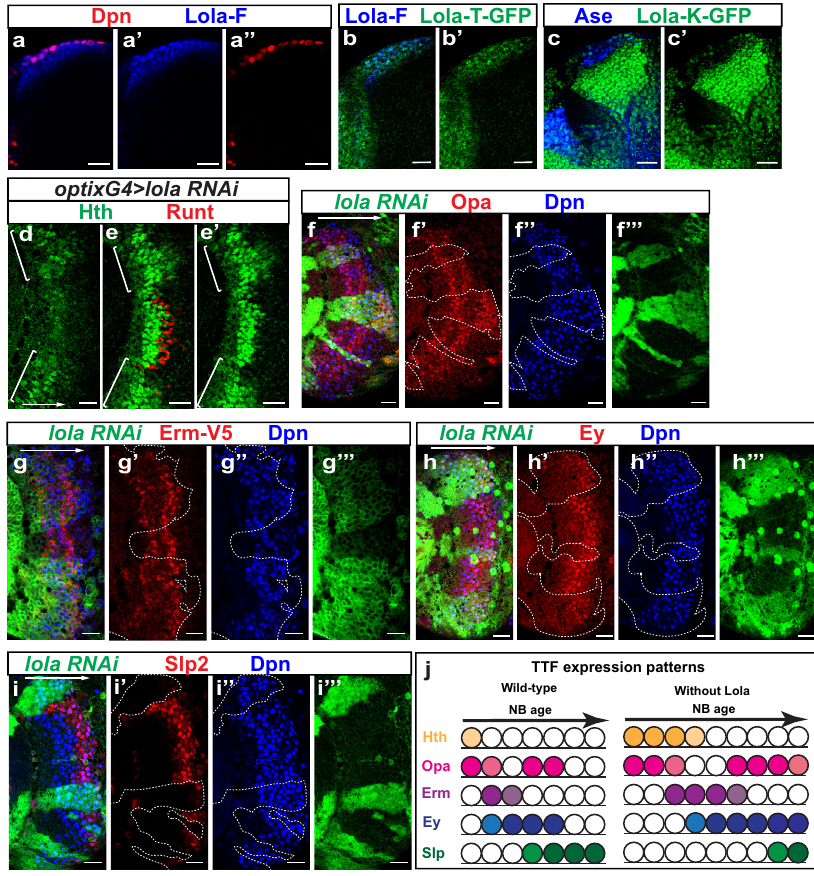
Fig. 6 Lola regulates the progression of the temporal cascade. a – a ” The expression of Dpn (red) and Lola-F (blue) in a cross-sectional view. b , b ’ The expression of Lola-T::GFP (green) and Lola-F (blue) in a cross-sectional view. c , c ’ The expression of Lola-K::GFP (green) and Ase (blue) marks both NBs and GMCs in a cross-sectional view. d – e ’ lola RNAi (BDSC35721) is driven by optixGal4 in mOPC indicated by white brackets. With lola RNAi, Hth (green) is expanded into older NBs ( d ) and later-born progeny ( e , e ’ ), whereas Runt neurons (red) are mostly lost ( e ) (in fi ve out of fi ve brains). f – f ”’ In lola-RNAi clones (VDRC 101925) marked by GFP (green), the second stripe of Opa (red) is activated in the 5th to 7th NB marked by Dpn (blue) (in 19 out of 19 brains), while its activation happens in the 3rd or 4th NB in wild-type regions. g – g ”’ In lola - RNAi clones (VDRC 101925), Erm-V5 (red) is activated in the 3rd or 4th NB marked by Dpn(blue) (in 16 out of 16 clones), whereas in wild-type regions, Erm-V5 is activated in the 2nd or 3rd NB. h – h ”’ In lola-RNAi clones (VDRC 101925), the activation of Ey (red) is observable in the 4th or 5th NB marked by Dpn (blue) (in 19 out of 19 clones), while wild-type Ey expression starts in the 2nd or 3rd NB. i – i ”’ In lola - RNAi clones (VDRC 101925), Slp2 (red) is activated in the 7th to 9th NB marked by Dpn (blue) (in 24 out of 24 clones), whereas in wild-type part of the brains, Slp2 is activated in the 4th or 5th NB. j A schematic showing the function of Lola in regulating the temporal cascade. Loss of Lola causes slowing down of the temporal progression. In wild type, only seven NBs were shown because later TTFs were not examined. Scale bars: 20